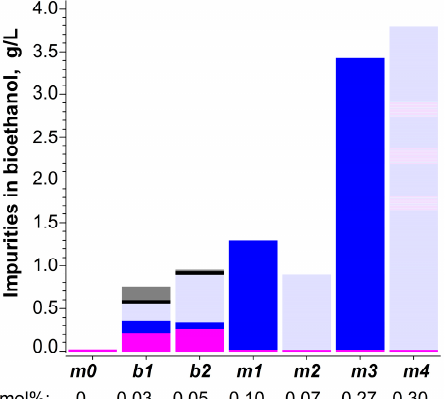
Figure 8. Impurities in the samples: pure ethanol ( m0 ), real bioethanol ( b1, b2 ), model ethanol contaminated with n-PrOH ( m1, m3 ), same, contaminated with i-PrOH ( m2, m4 ). Impurities: AA ( ), methanol ( ), i-PrOH ( ) , n-PrOH ( ) , isobutanol ( ). The molar percentage of C3-alcohol in the gas phase is given below.